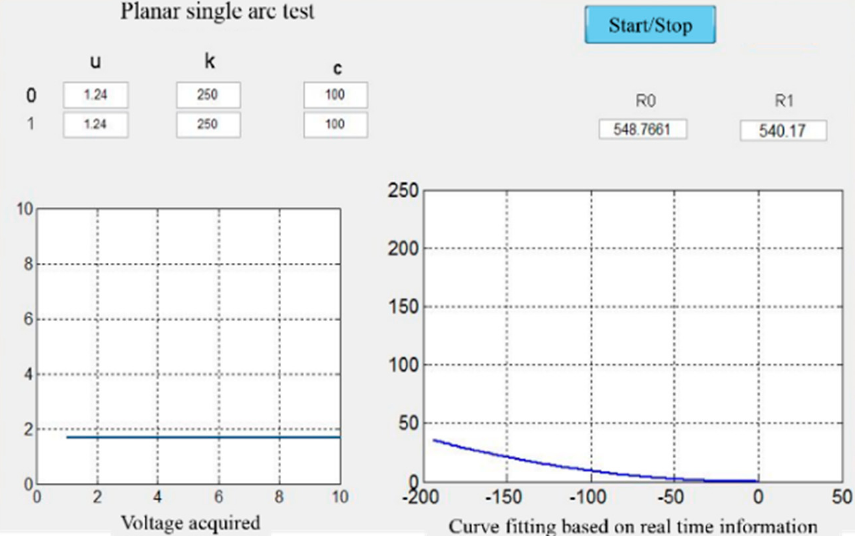
Figure 15. Experiment results.